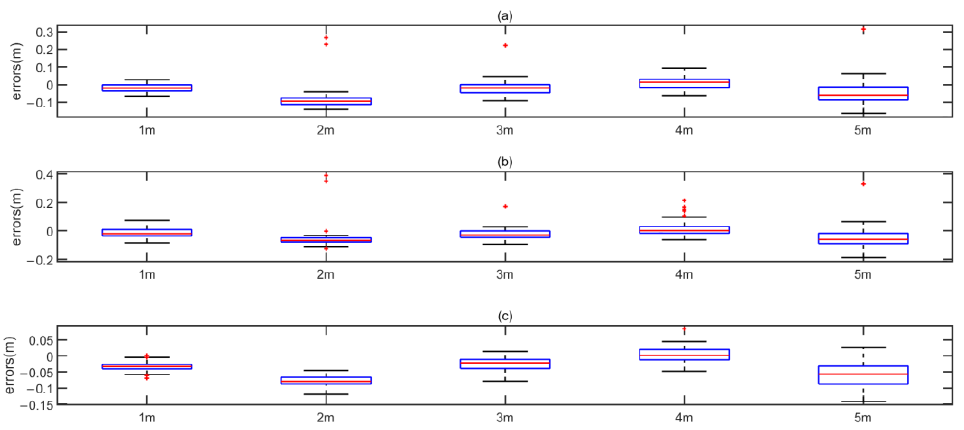
Figure 23. Error distribution in Case 1. ( a ) ranging in method Peak. ( b ) ranging in method two-stage. ( c ) ranging in method env-two-stage.